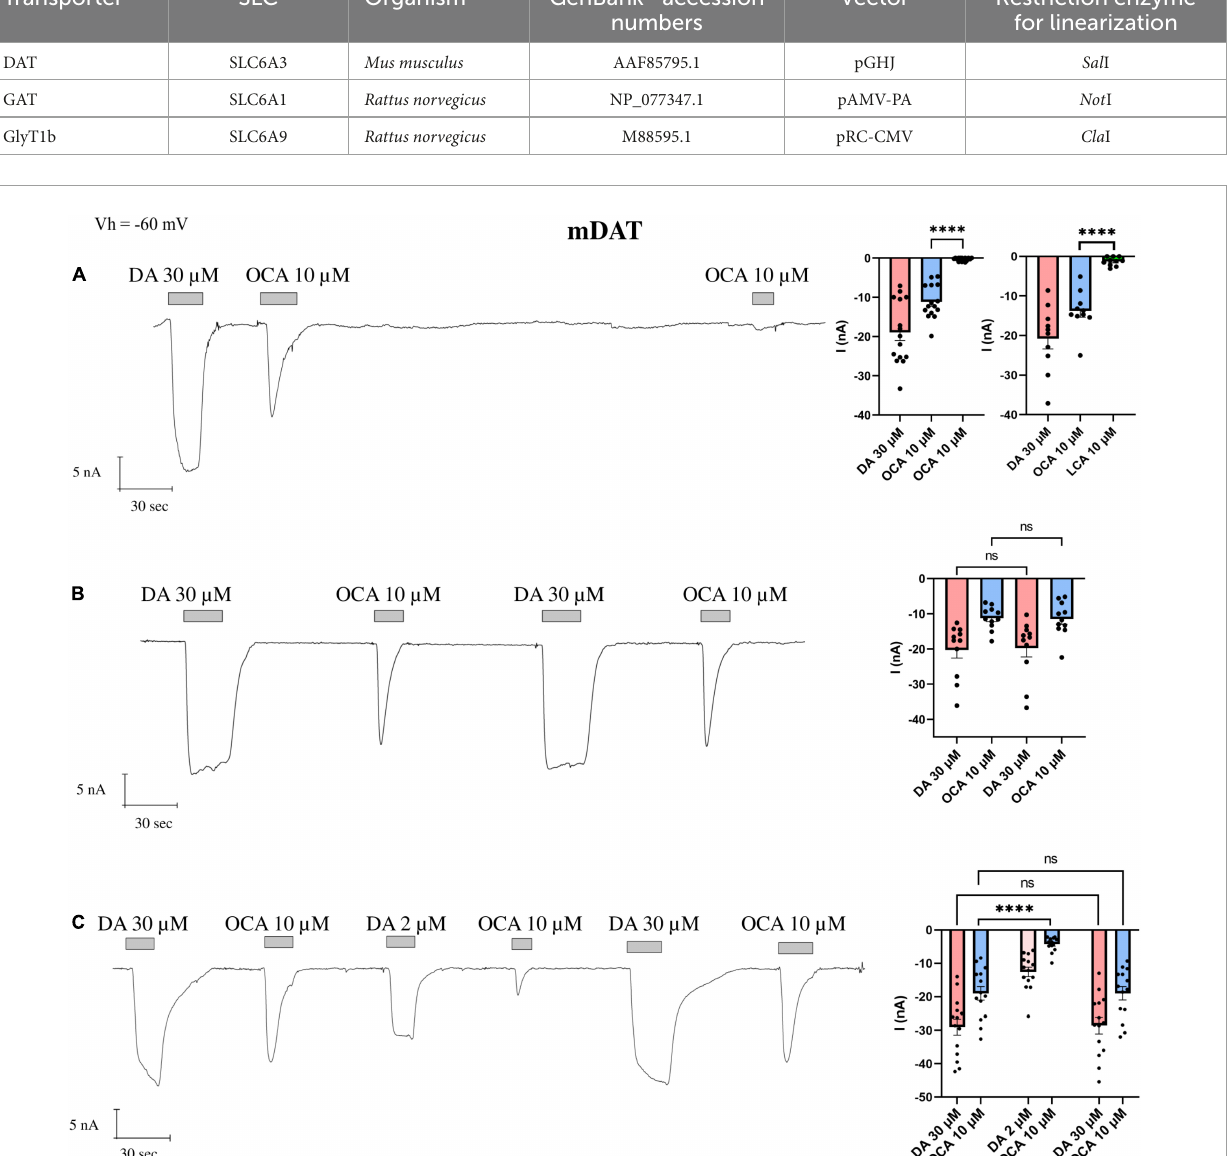
FIGURE1 The displacement of OCA from mDAT by DA. Representative traces of currents recorded by TEVC from oocytes expressing mDAT exposed to OCA (left) and mean of the indicated currents (right). (A) Currents after the first and second exposure to OCA, with an interval of 5 (cid:48) wash with ND98 alone; mean current (nA) ± SE, from n = 15 oocytes, n = 4 batches; I 0 OCA vs. I’ OCA on the same oocyte: one-way ANOVA F ( 2 , 42 ) = 18.15, ∗∗∗∗ p < 0.0001 followed by Bonferroni’s multiple comparison test; I 0 ∗∗∗∗ p < 0.0001. (B) Currents after the first and second OCA vs. I’ LCA same oocyte: exposure to OCA with washing ND98 and ND98 plus DA 30 µ M after the first OCA exposure; mean current (nA) ± SE of 11/3 n/N; repeated measure one-way ANOVA F ( 1 . 220 , 12 . 20 ) = 20.71, p = 0.0001 between columns and F ( 10 , 30 ) = 9.253, ∗∗∗∗ p < 0.0001 between rows, followed by Bonferroni’s multiple comparison test. I DA vs. I’ DA : p = 0.8737 and I 0 OCA vs. I’ OCA : p > 0.9999. (C) Currents after the first and second exposure to OCA with washing ND98 and ND98 plus DA 2 µ M after the first OCA exposure; mean current (nA) ± SE of 13/2 n/N; repeated measure one-way ANOVA F ( 2 . 838 , 36 . 89 ) = 62.26, ∗∗∗∗ p < 0.0001 between columns and F ( 13 , 65 ) = 10.44, ∗∗∗∗ p < 0.0001 between rows followed by Bonferroni’s multiple comparison test. I DA vs. I’ DA : p > 0.9999; I 0 OCA vs. I” OCA : p > 0.9999; I 0 OCA vs. I‘ OCA after DA 2 µ M: ∗∗∗∗ p <